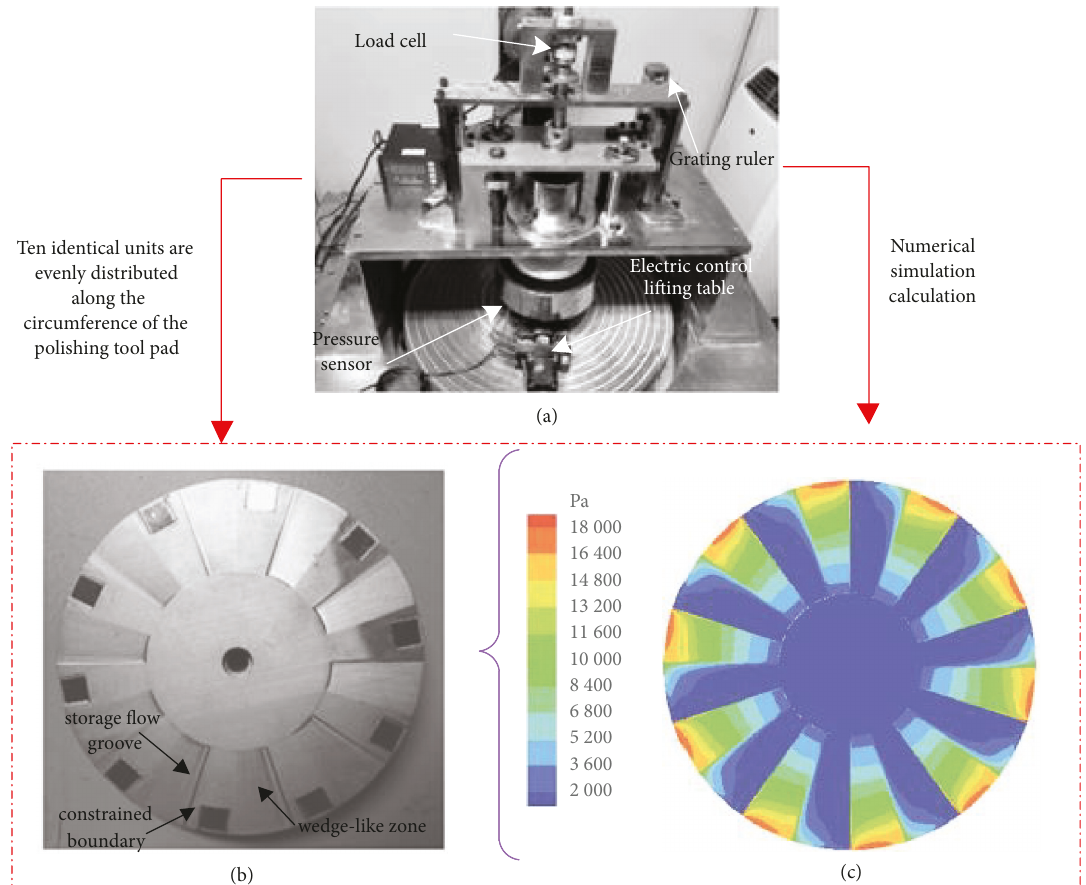
Figure 22: Hydrodynamic floating polishing machine [114]. (a) HFP polishing experiment. (b) HFP tool pad structure. (c) Nephogram of dynamic pressure of HFP tool